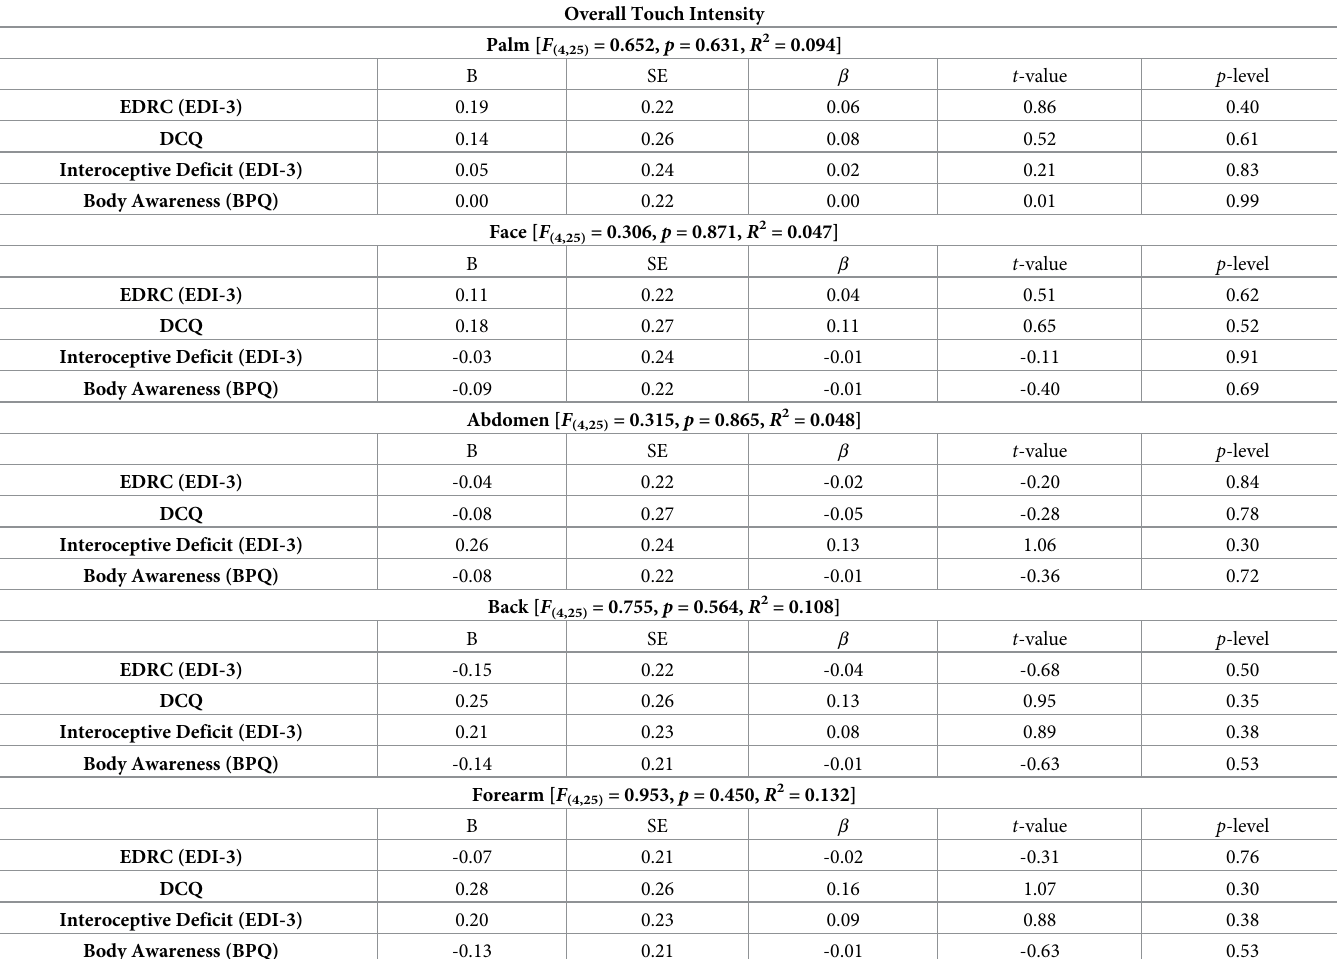
Table 3. Unstandardized coefficients from linear simultaneous multiple regression models of eating and dysmorphic concerns and body awareness predictors of the overall touch intensity index at each body site (palm, face, abdomen, back and